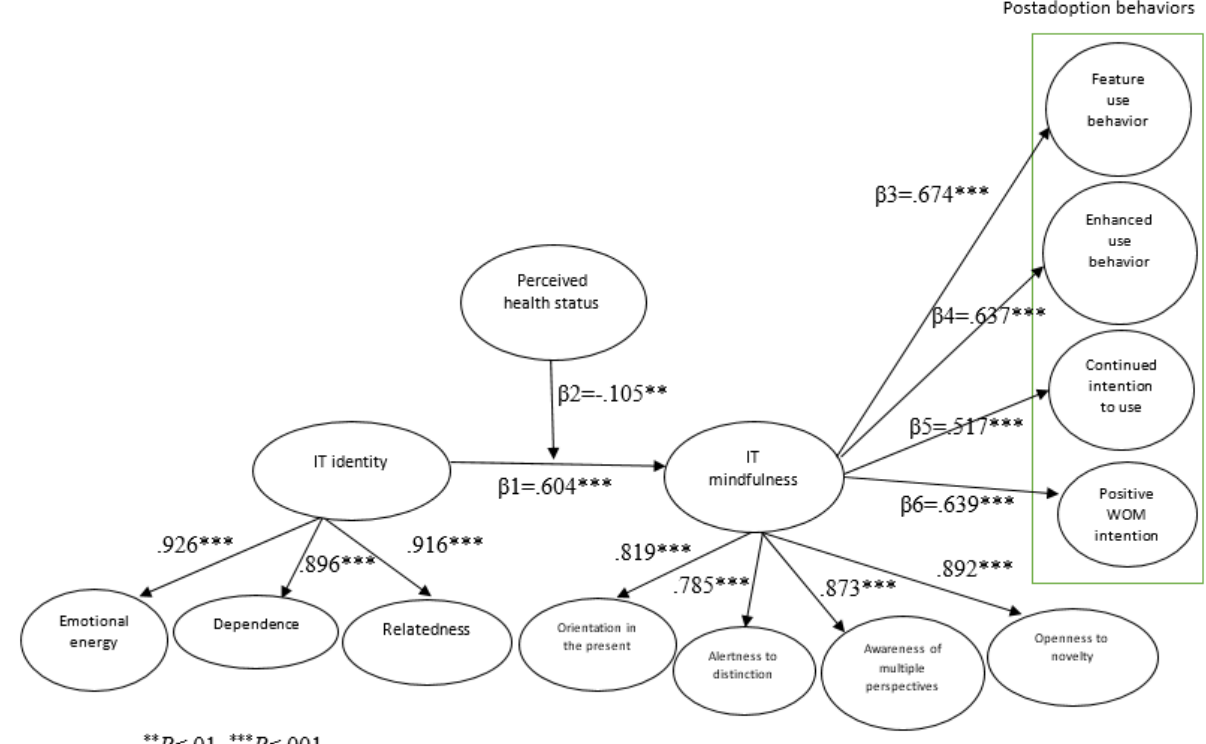
Figure 2. Model paths. IT: information technology; WOM: